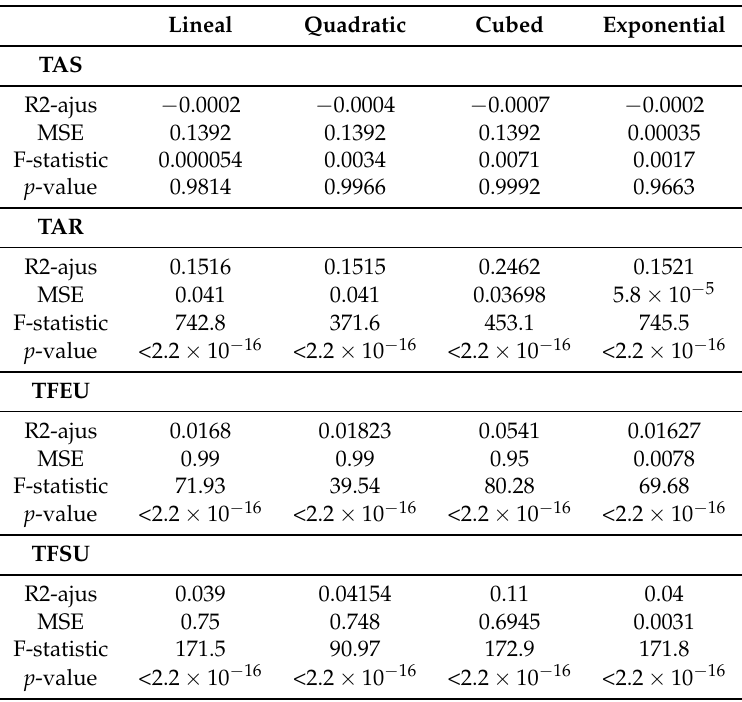
Table 3. Linear regression results.